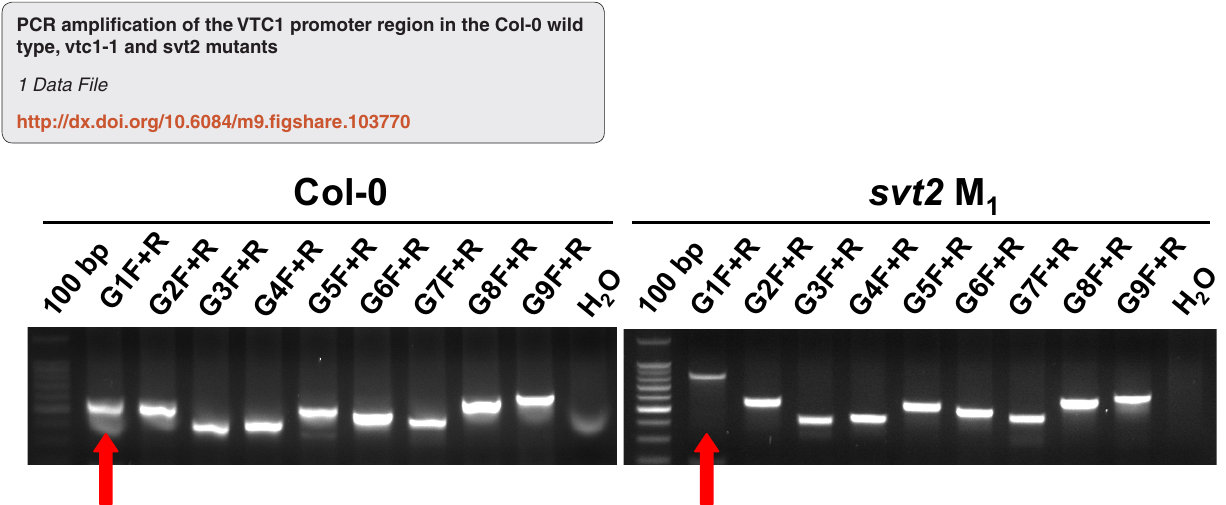
Figure 6. Molecular characterization of svt2 . Amplification of the VTC1 gene including ~500 bp of the promoter region using a series of nine, overlapping primers (G1F+R through G9F+R) in both Col-0 wild type and svt2 M a negative control (water instead of DNA). Red arrows indicate the different sized PCR products using the same primer set.